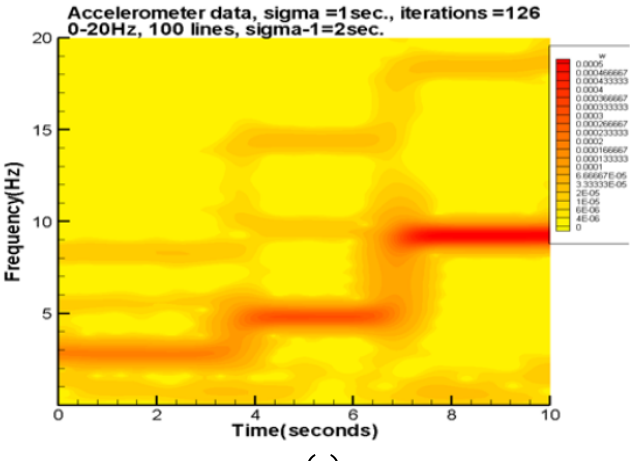
Figure 6. Spectrograms corresponding to those shown in Figure 5: (a) the accelerometer. (b) microphone-1 attached to the membrane. (c) microphone-2 at 10 cm above the